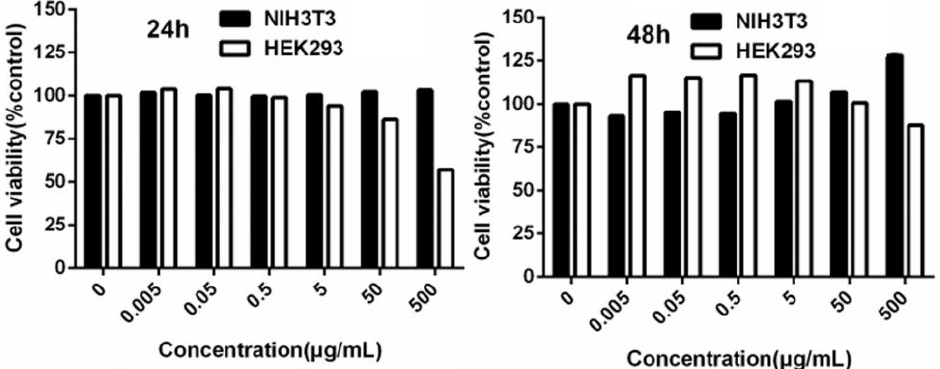
Figure 9. MTT toxicity assays of complex 1 on HEK-293 and NIH-3T3 cells at 24 h and 48 h, re- spectively.